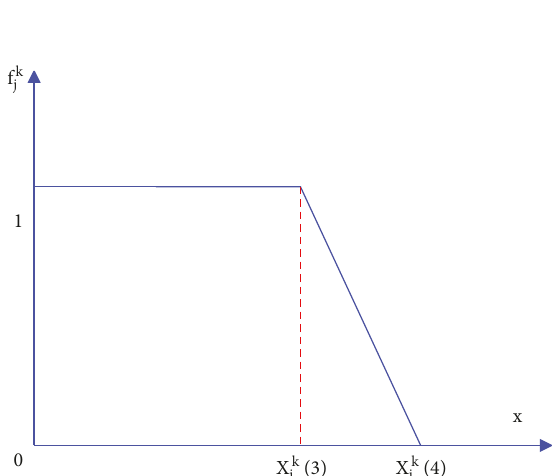
Figure 5: Schematic diagram of the lower limit measurement